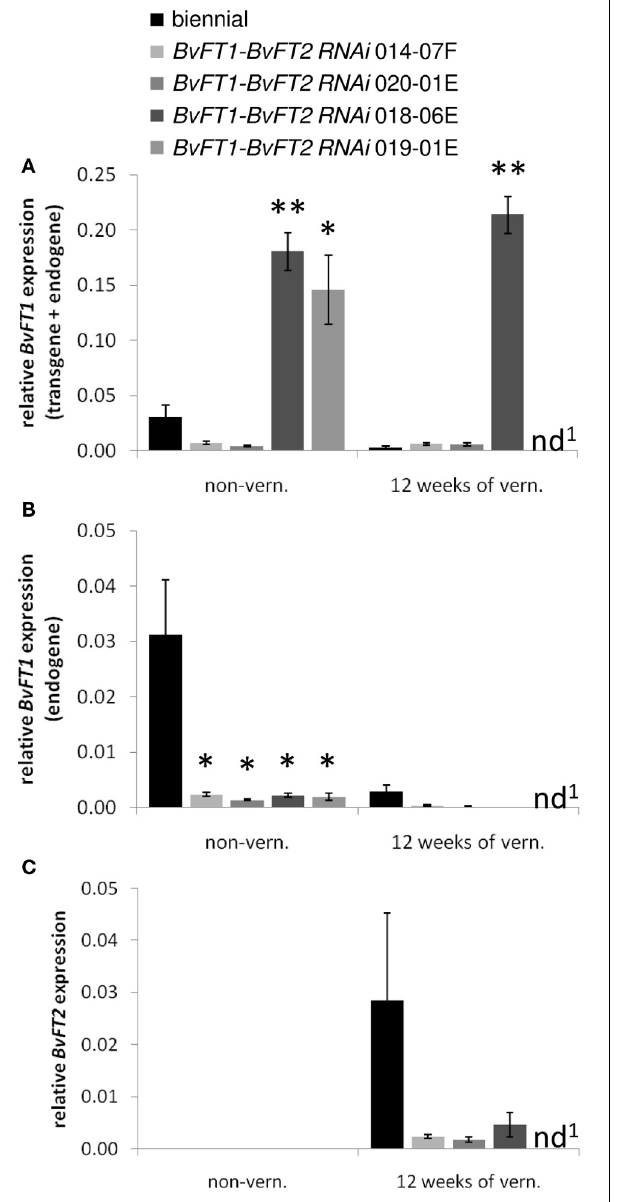
FIGURE 3 | Expression of BvFT1 (A,B) and BvFT2 (C) in BvFT1-BvFT2 RNAi transformants. Expression was measured in leaves of non- vernalized plants and at the end of a 12-week vernalization period at ZT 6-8 under long-day conditions. BvFT1 expression was determined either with primers which co-amplify endogenous and transgenic BvFT1 transcripts (A) or with primers which specifically amplify the endogenous BvFT1 transcript (B) . Expression analysis, normalization, and statistical analysis was performed as described for Figure 1 . nd, not determined. Significant differences between expression levels in the transformants and the control plants are indicated by asterisks ( ∗ α = 0 . 05, ∗∗ α = 0 . 01 according to Student’s t -test). during the light cycle compared to the control plants, resulting in a peak of expression at ZT 12. BvLHP1 expression in the dark was in phase with the control. Expression of BvGI ( Figure 4D ) and BTC1 ( Figure 4E ) was similar as reported previously (Pin